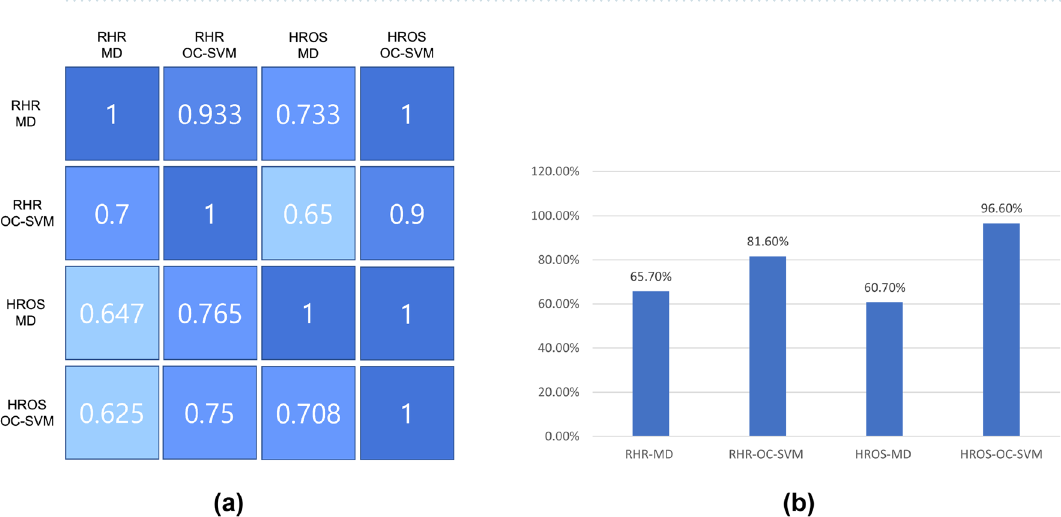
Table 3. Comparison of anomaly detection instances of RHR-MD, RHR-OC-SVM, HROS-MD, and HROS- OC-SVM: blue dots are outliers found by OC-SVM, red dots are outliers found by MD-MCD, and orange dots are outliers found by both OC-SVM and